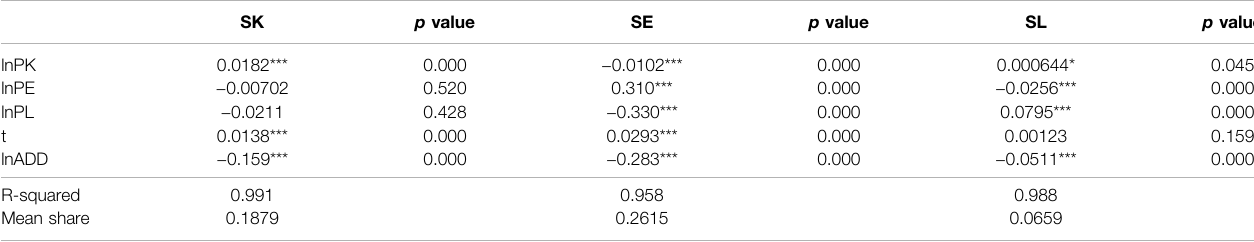
TABLE 3 | The results of cost share equations.